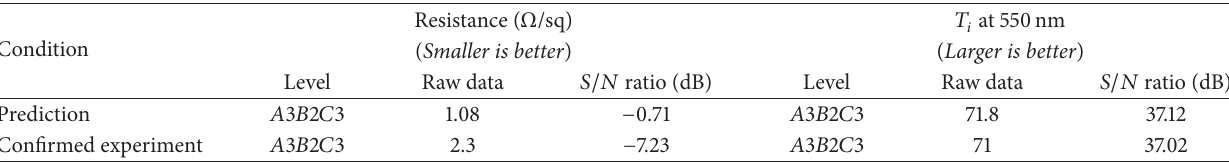
Figure 10: (a) Visible transmittance and (b) resistance and roughness of ZA(8)Z films as a function of PDA temperature and (c) FOM of ZA(10)Z and ZA(8)Z as a function of PDA temperature. Table 4: Comparison of the predicted resistance ( Ω /sq) and transmittance value (%) for the ZAZ multilayers with the experimental results using the optimal experimental